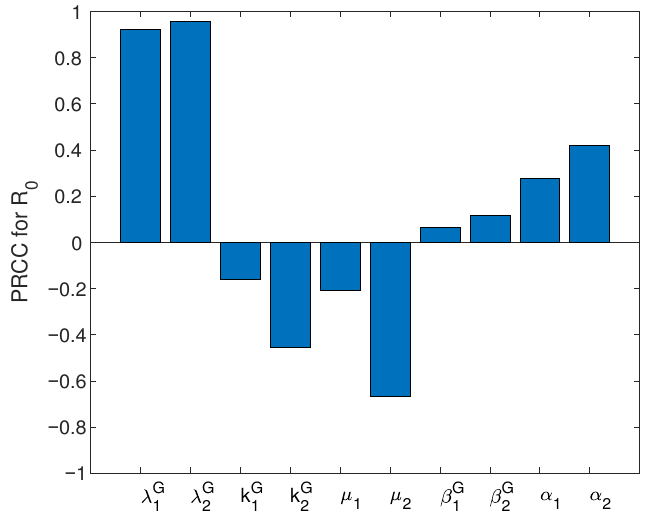
Figure 7. PRCC value of R 0 with λ G